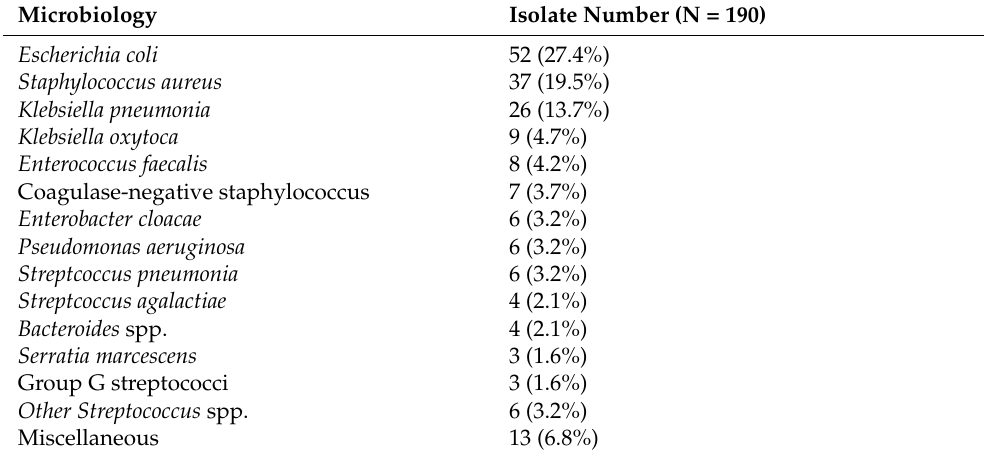
Table 2. Micro-organisms isolated in bacteremia.